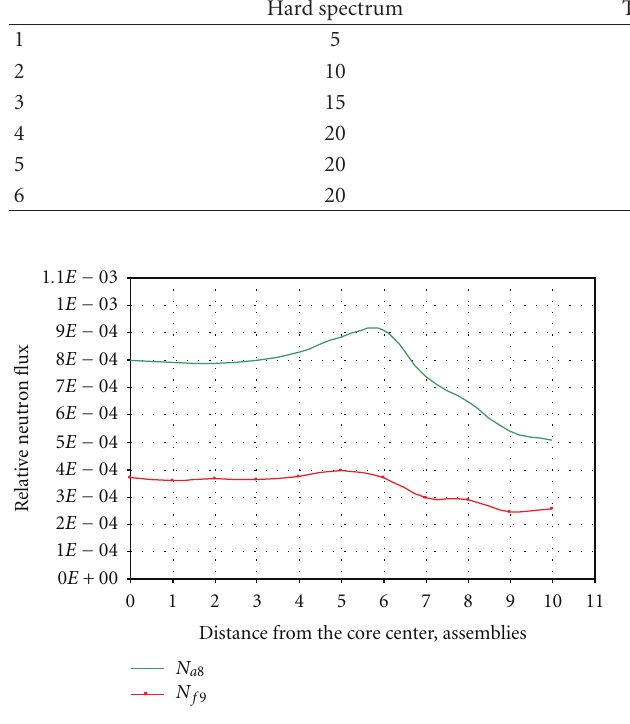
Figure 5: Radial distribution of neutron absorption in 238 U ( N a 8 ) and fissions on 239 Pu ( N f 9